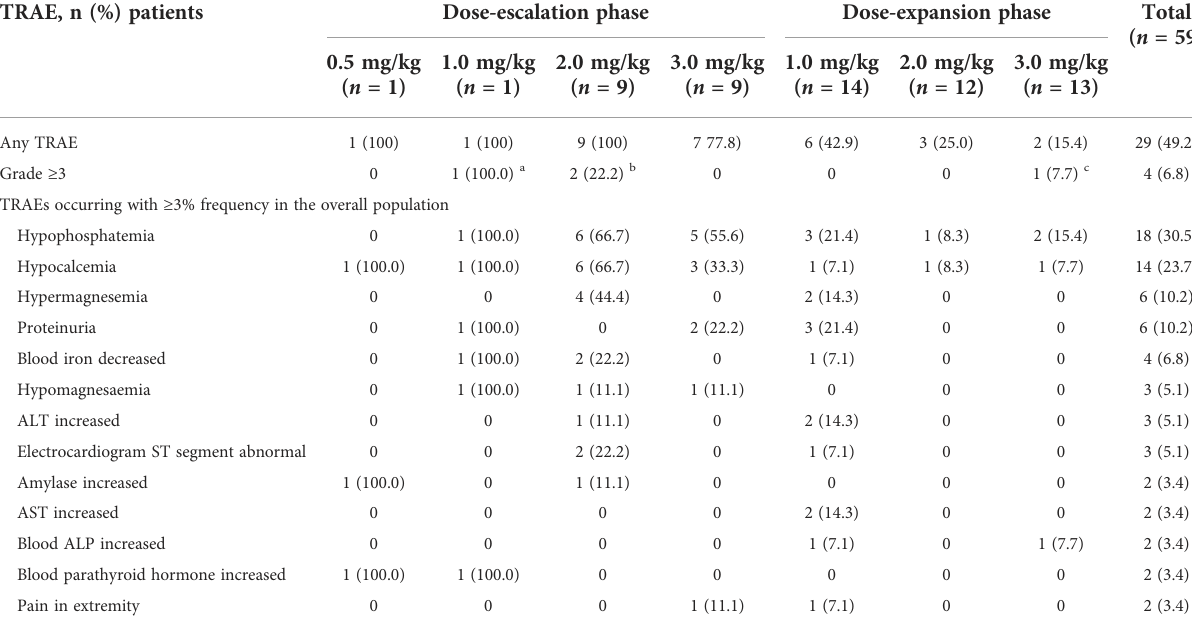
TABLE 3 Summary of treatment-related adverse events of JMT103 in the